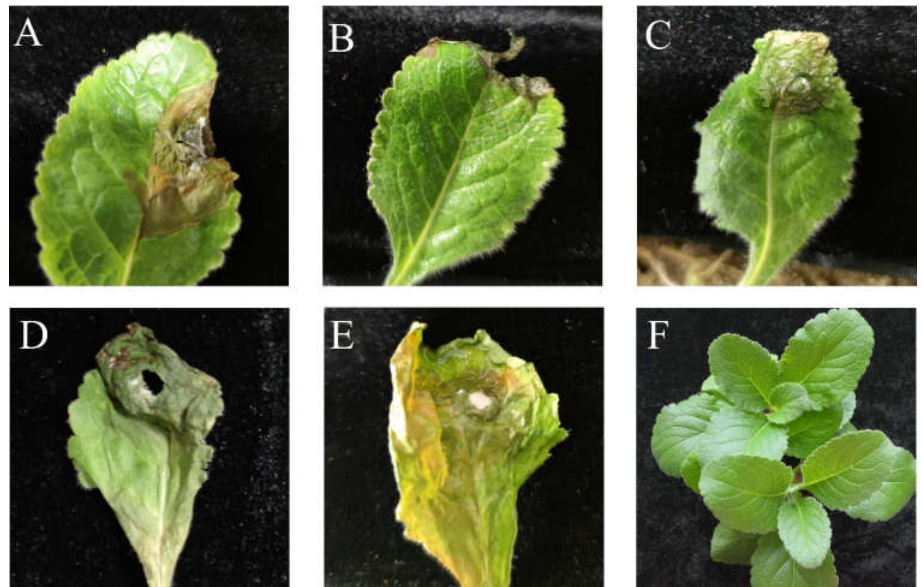
Figure 1. Symptoms of Rehmannia glutinosa leaves inoculated with pathogens at 7 days. ( A ) Leaves inoculated with HHAUF210507; ( B ) leaves inoculated with HHAUF210509; ( C ) leaves inoculated with HHAUF2105013; ( D ) leaves inoculated with HHAUF210502; ( E ) leaves inoculated with HHAUF2105015; ( F ) control.